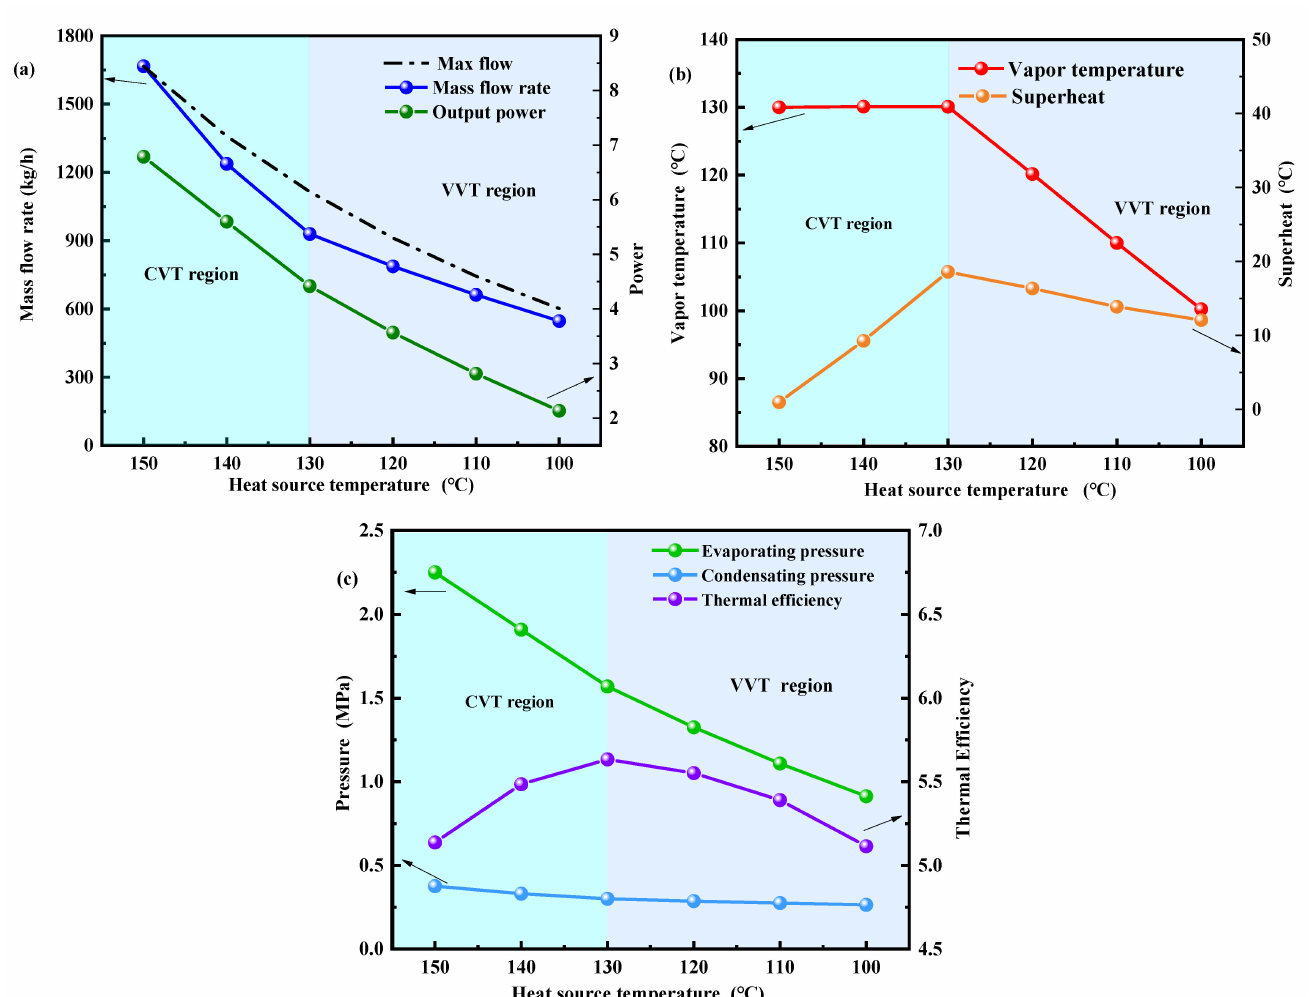
Figure 10. Variation of key parameters of the ORC system with the heat source temperature under CVT mode. ( a ) mass flow rate and power, ( b ) vapor temperature and superheat, ( c ) vapor pressure and thermal